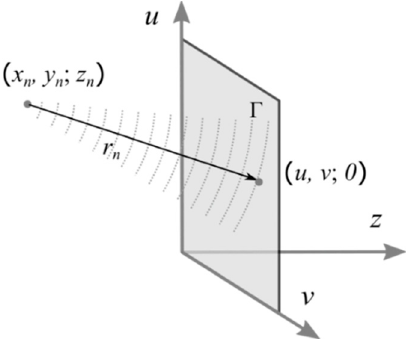
Figure 1. Schematic illustration of reference beam rendering process.